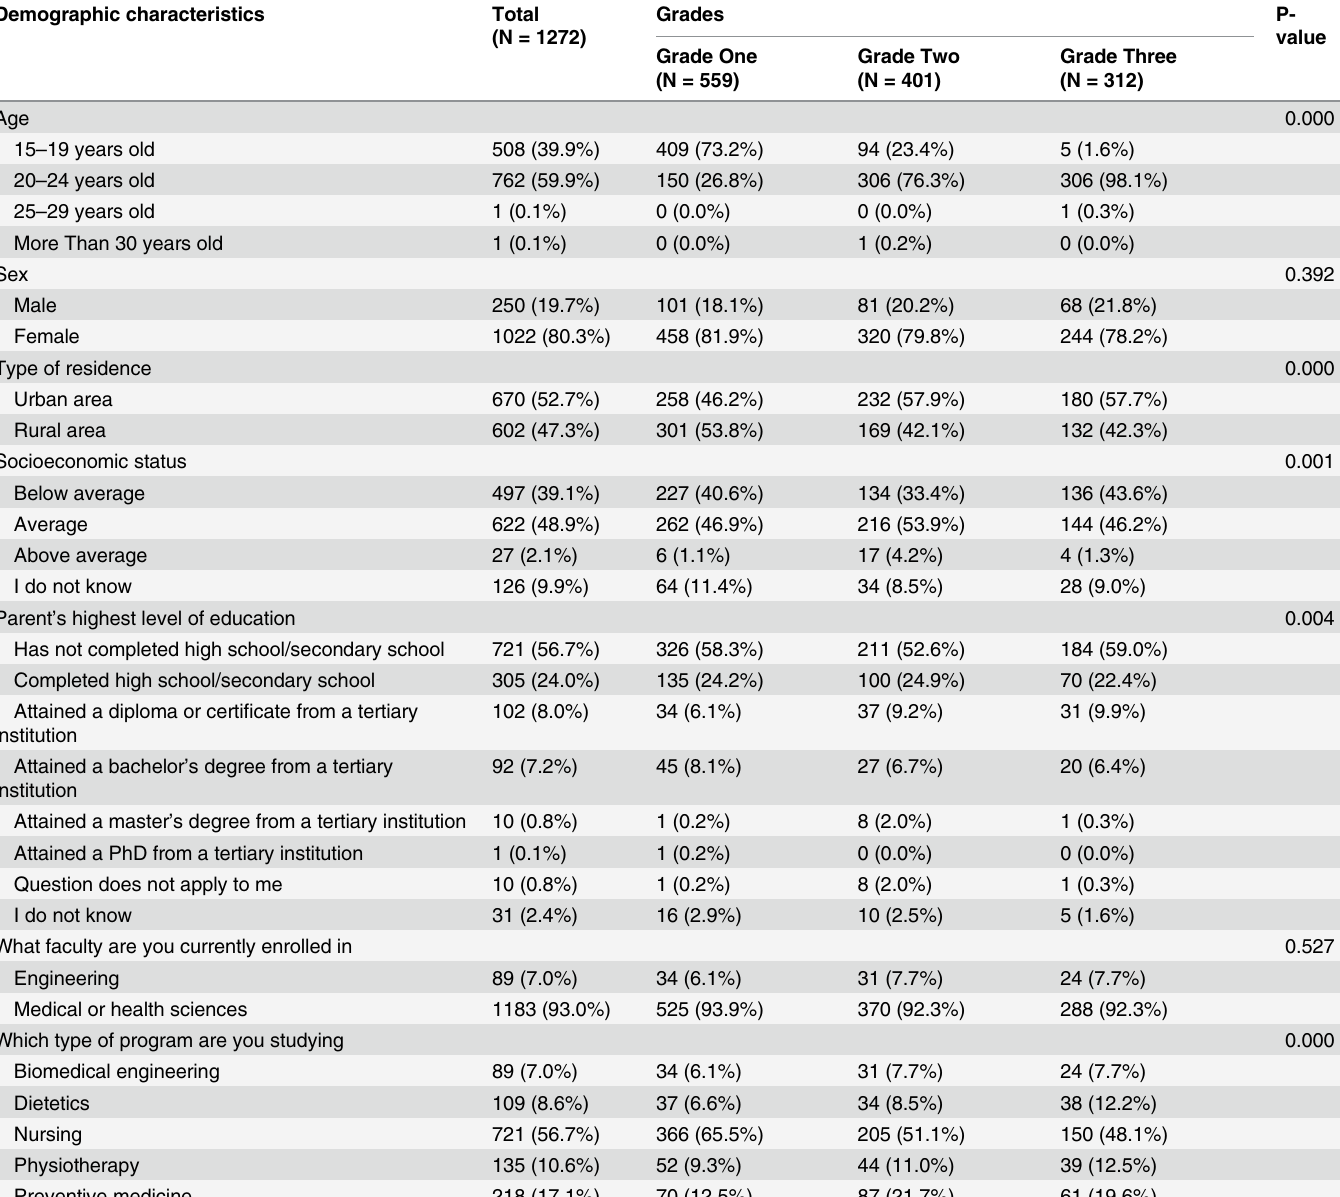
Table 1. Demographic Characteristics of Different